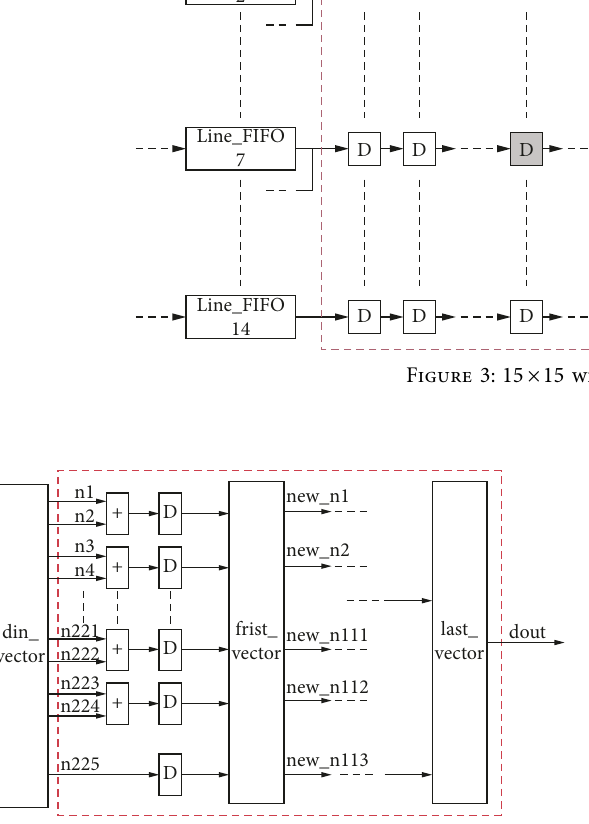
Figure 4: Recursive summation block diagram.